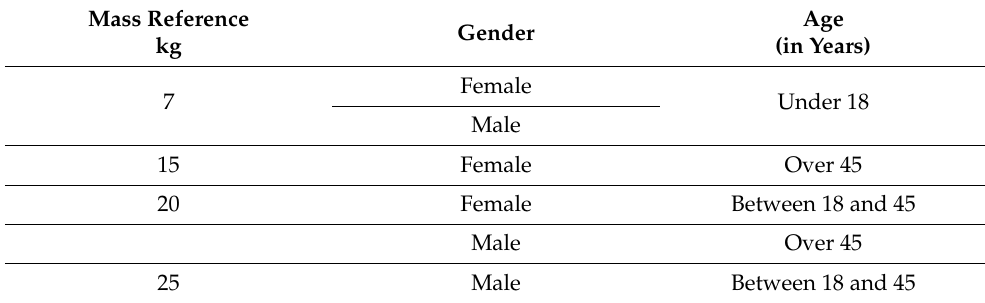
Table A2. Reproduction of Table 1 maximal mass reference that can lift or down a worker, sorted by age and gender contained in the Mexican Standard NOM 036-1:2018 [6].